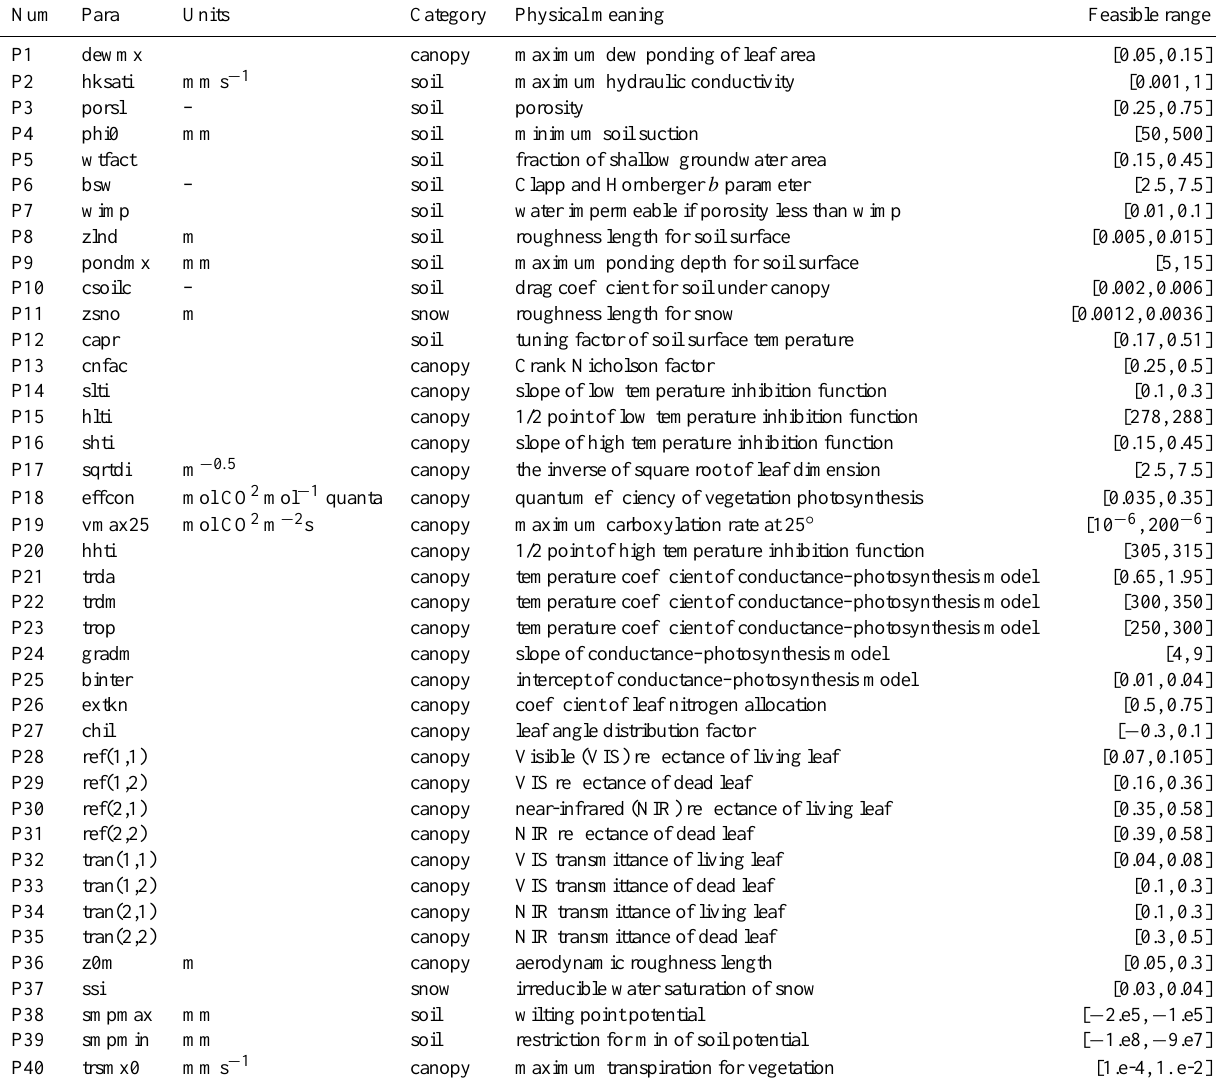
Table 1. Adjustable parameters and their categories, meanings and ranges.